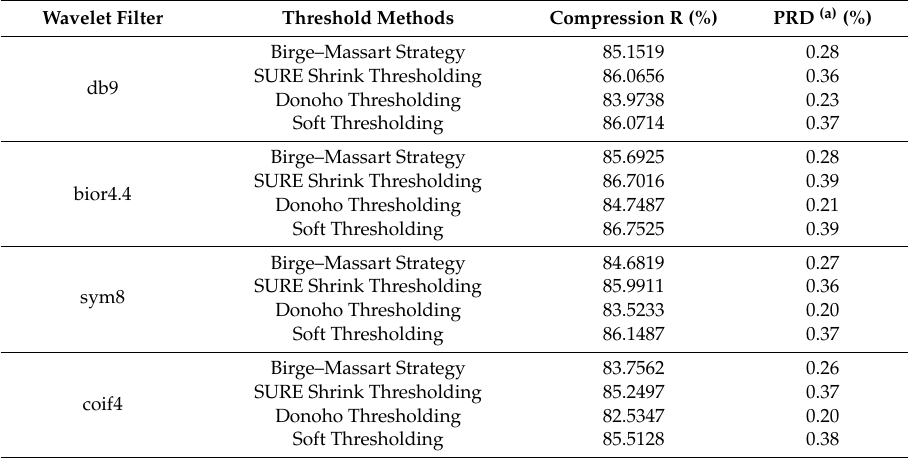
Table 2. Compression rate and data distortion of di ff erent wavelet compression methods.